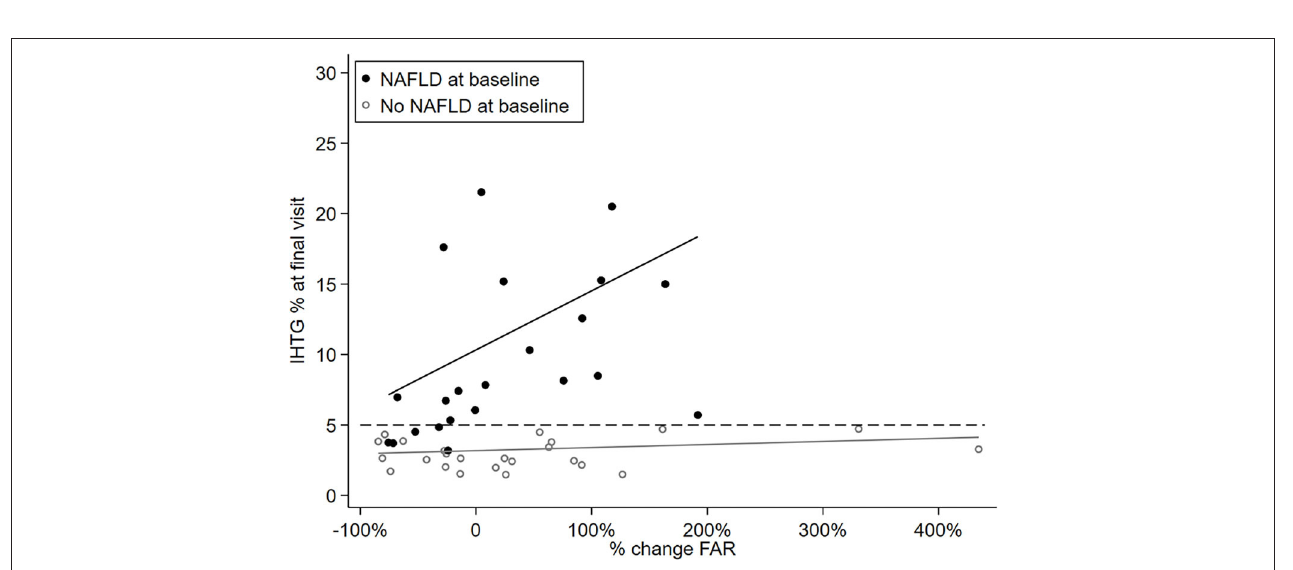
FIGURE 3 | Scatterplot showing linear association between hepatic fat percent at final visit and percent change in the FAR by baseline NALFD